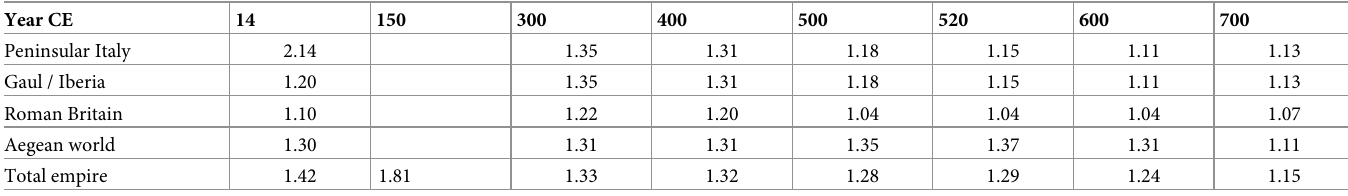
Table 4. Per capita income for the Roman world, by European